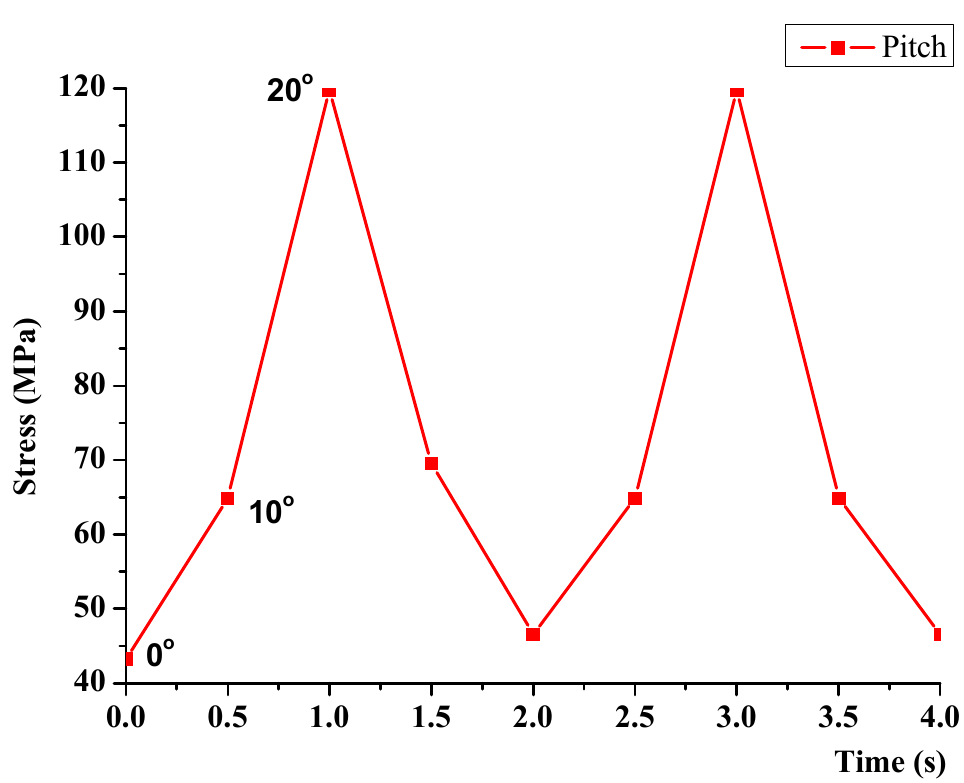
Figure 16. The stress trend chart of the pitch motion. According to the analysis results, it can be seen that the multi-axis platform mechanism was safe during movement, the overall stress was within the yield strength 648.5 MPa of material S45C, and the material safety factor N was